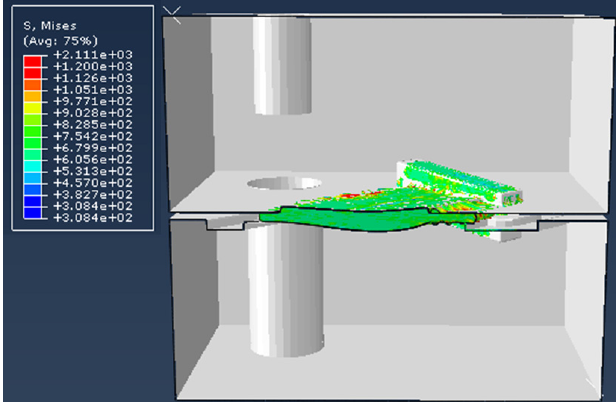
Figure 4. Filling of high Nb–TiAl alloy billet in the simulated process.